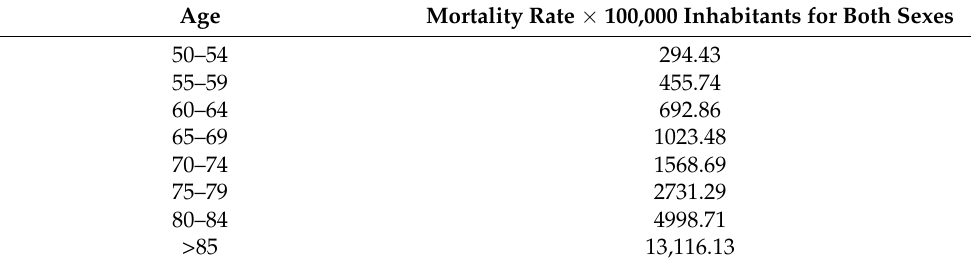
Table 5. Gross mortality rate for both sexes in Spain in 2016 according to